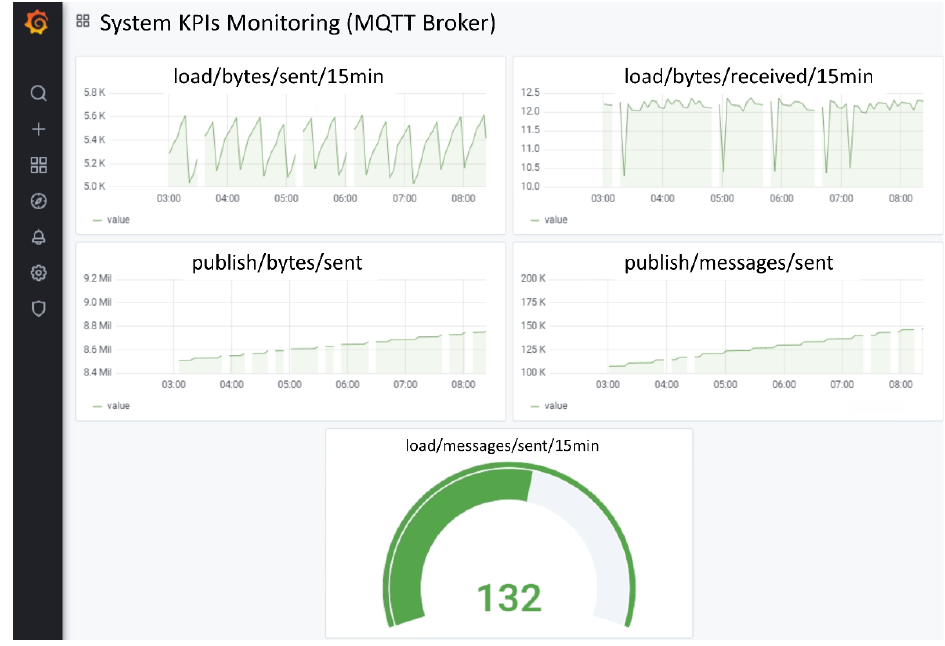
Figure 6. A dashboard of MQTT Broker KPIs.